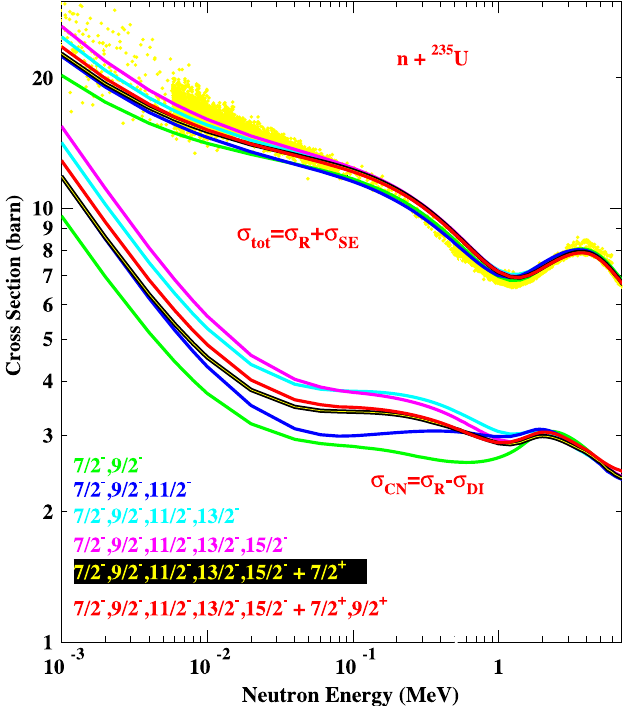
Fig. 2. Total ( s tot ) and compound nucleus formation ( s CN ) cross-sections obtained increasing the number of coupled levels in the coupled channel approach for neutron induced reaction on 235